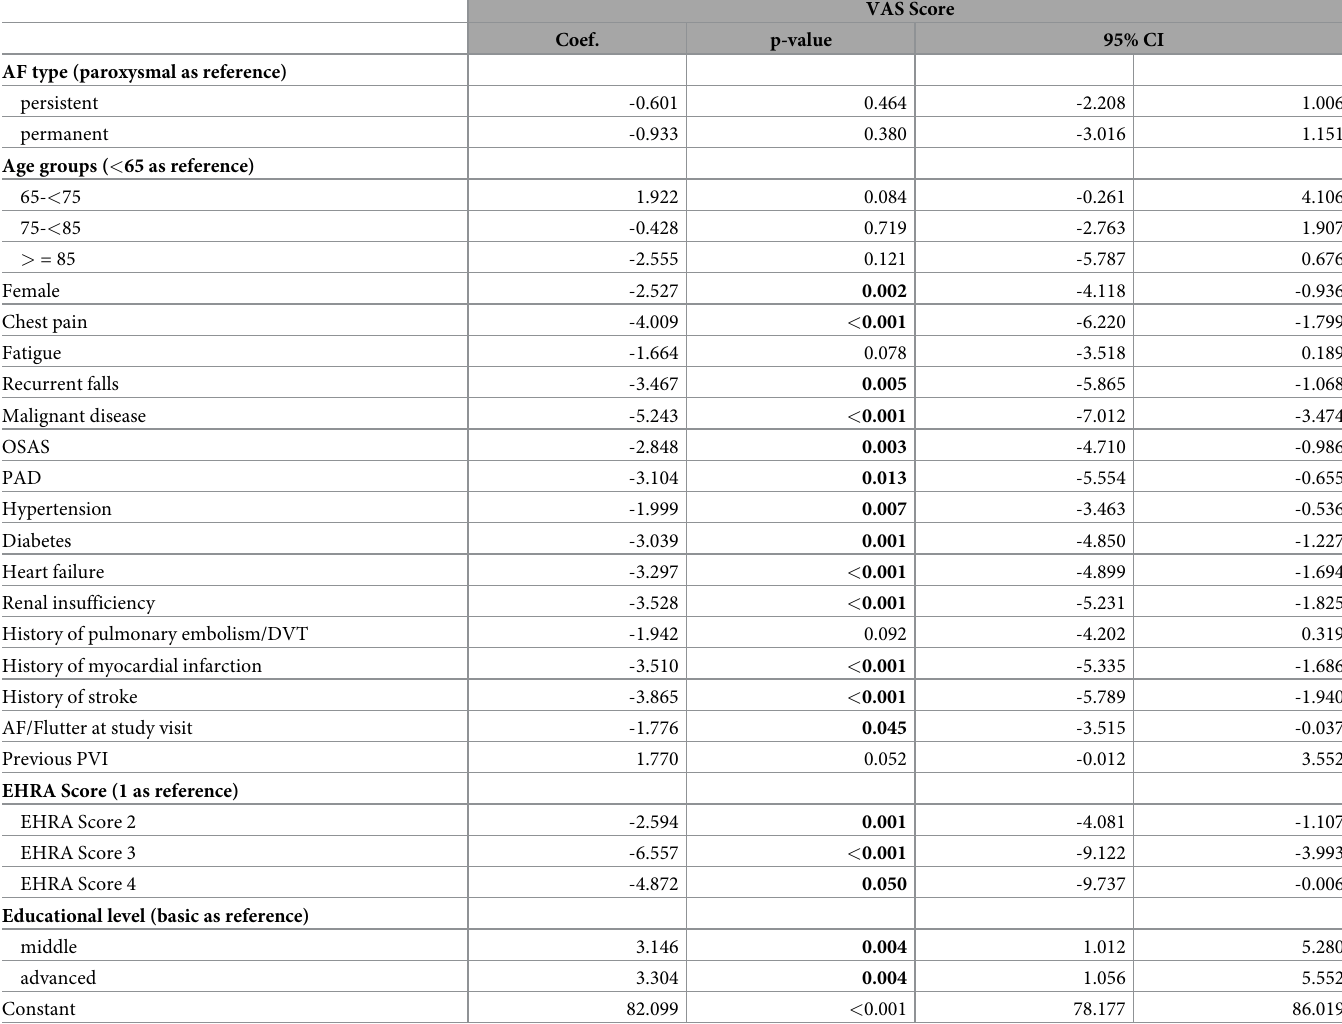
Table 5. Multivariable regression analysis: Predictors of the VAS score in AF patients. Joint p values: AF type p = 0.634, age p < 0.001, EHRA Score p < 0.001, Education level p = 0.010. Study centre was included as random effect in the model. OSAS, obstructive sleep apnoea syndrome; PAD, peripheral artery disease; DVT, deep vein thrombosis; TIA, transient ischemic attack; EHRA, European Heart Rhythm Association; PVI, pulmonary vein